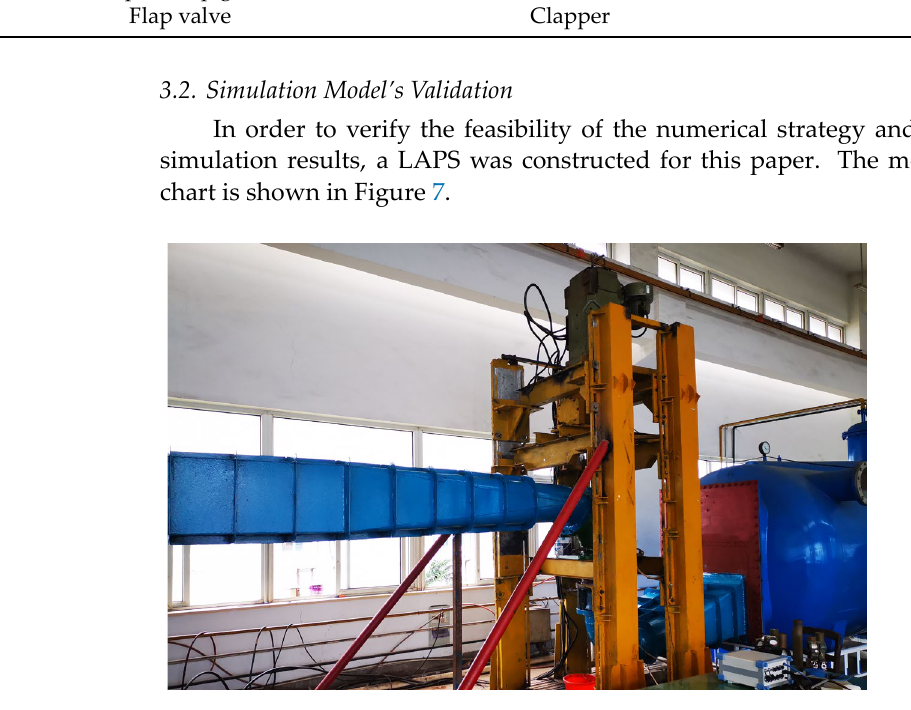
Figure 6. Schematic diagram of the LAPS simulation model.